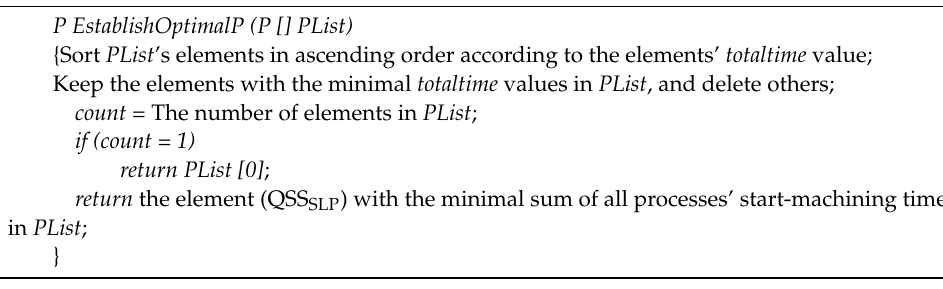
Algorithm 3 EstablishOptimalP.//Selecting the optimal QSS SLP